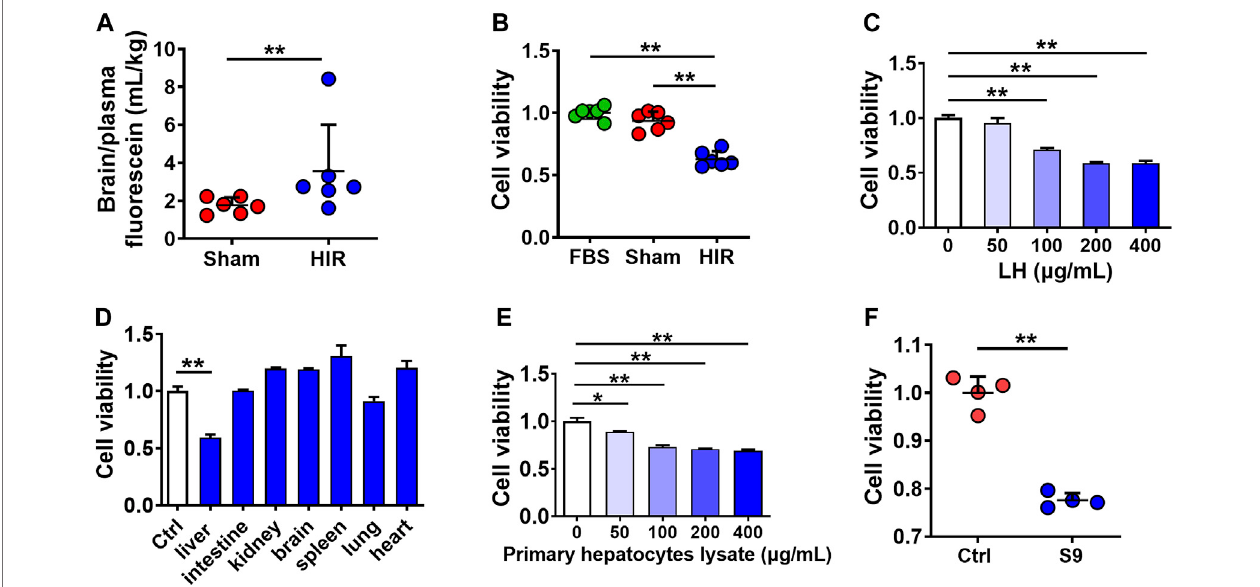
FIGURE 1 | Toxic molecule to BBB under HIR came from the liver under HIR. (A) BBB permeability indexed as the ratio of brain to plasma fl uorescein following intravenous injection (2 mg/kg) into hepatic ischemia-reperfusion (HIR) rats (1 h ischemia and 4 h reperfusion) and sham-operated (Sham) rats ( n (cid:2) 6). (B) Effect of 10% serum ofHIRratsonhCMEC/D3cellviabilitycompared with10%fetalbovineserum(FBS)andserumofshamrats( n (cid:2) 6). (C) Effectofhealthyratliverhomogenate(LH), (D) different tissues homogenates (200 μ g/ml), (E) primary hepatocyte lysate from healthy rats, and (F) human liver S9 (supernatant of 9,000 g centrifugation) (200 μ g/ml)onhCMEC/D3cellviability( n (cid:2) 4).Datawereexpressedasmean ± SD.* p < 0.05,** p < 0.001versuscontrolcells(Ctrl)orShamrats;1-wayANOVAfollowed by Dunnett ’ s post hoc test or unpaired t -test in panels (A,F) .